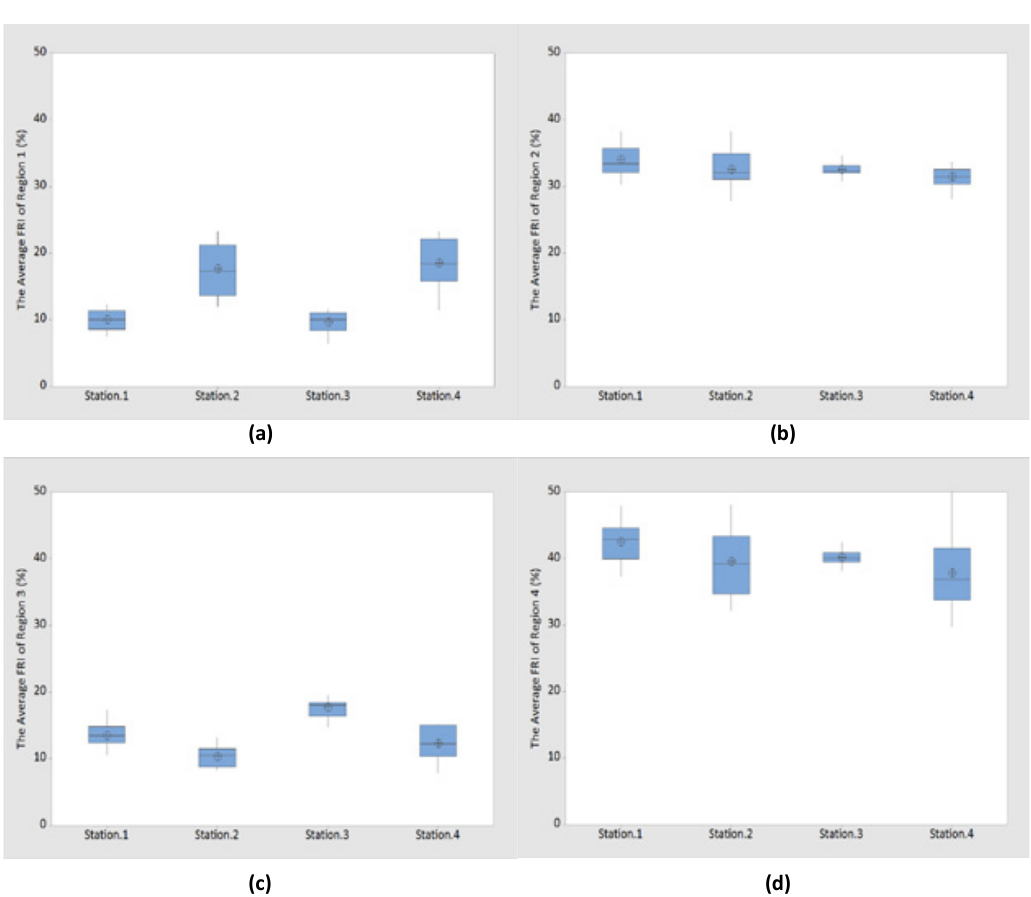
Fig. 7: The average percentage FRI of fluorescence organic matter in the river segment at various stations